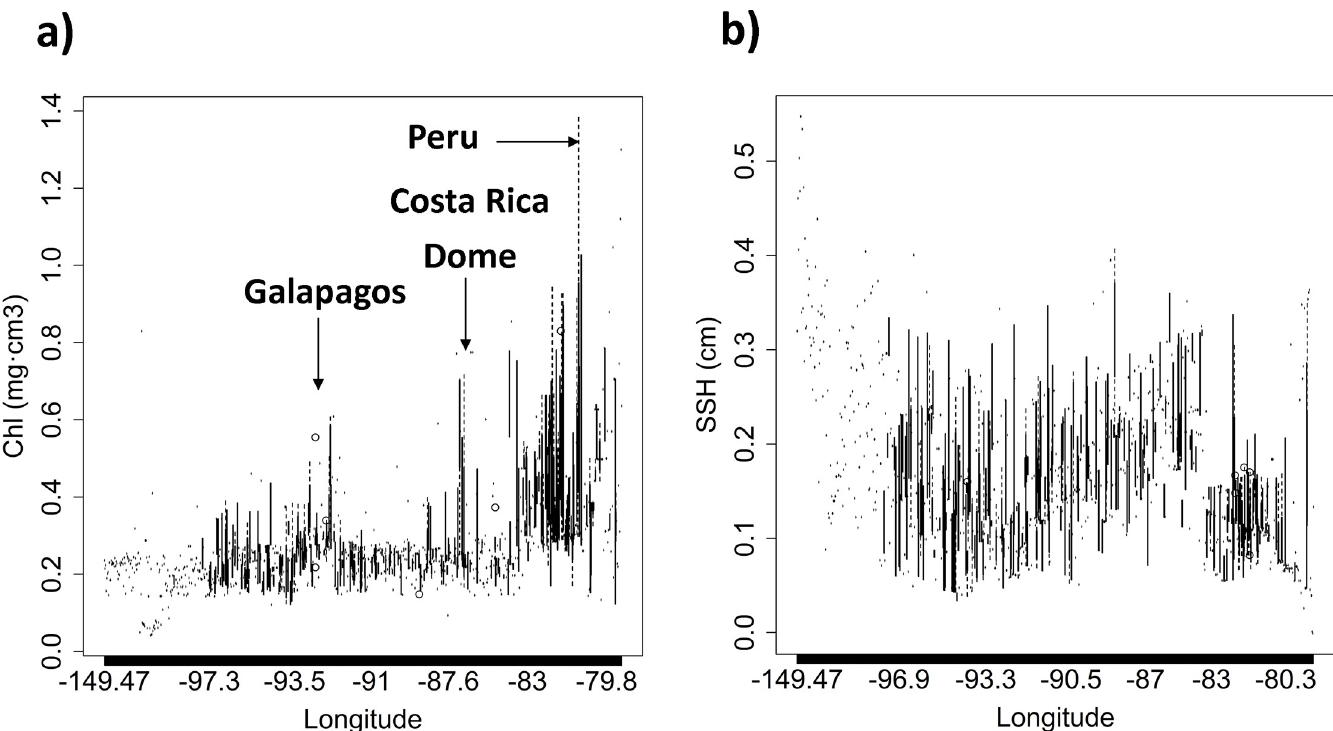
Fig 4. Lineplots showing the sets (longitude values in x-axis) with presence of Mobula mobular and their associated a) Chlorophyll concentrations (Chl, in y-axis) and b) Sea surface height (SSH, in y-axis) values.